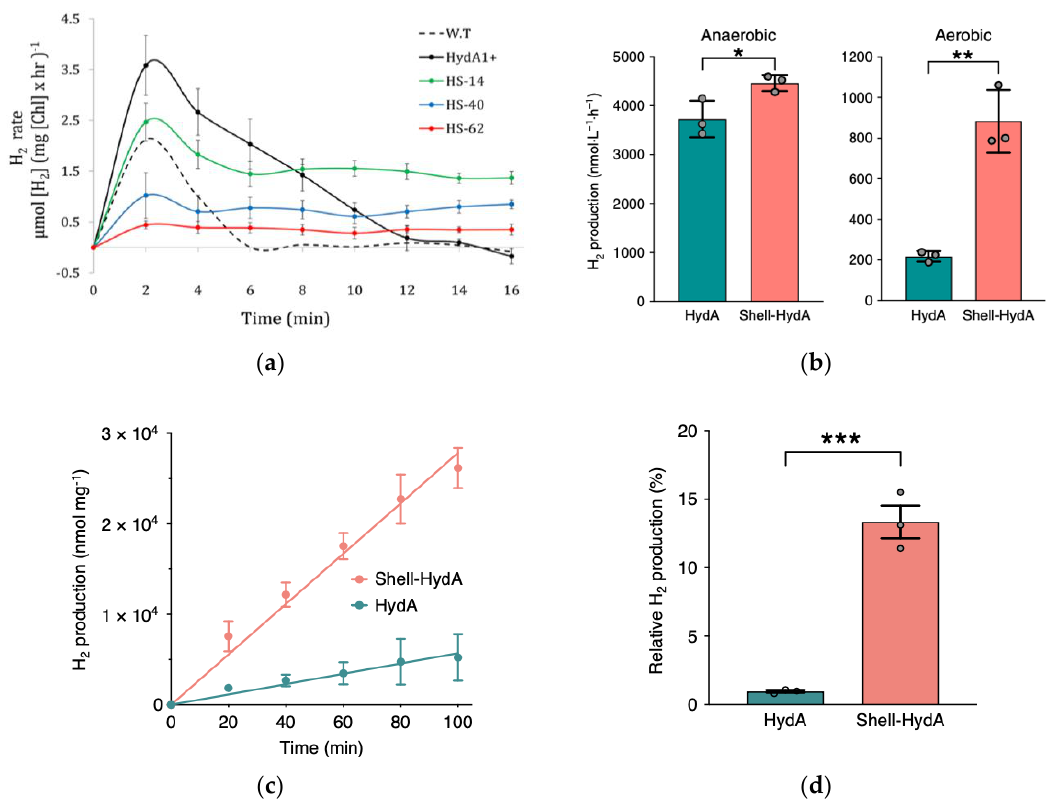
Figure 1. ( a ) HydA-SOD and clones of the complex rates of reaction over time. Reprinted with permission from ref. [3]. 2019 Springer Nature. ( b ) In vivo testing of anaerobic and aerobic pathways of H 2 production for Shell-HydA relative to free HydA enzyme (* signifies p = 0.0352 and ** signifies p = 0.0018). Reprinted with permission from ref. [41]. 2020 Springer Nature. ( c ) In vitro enzyme-mediated H 2 production over time of Shell-HydA composite relative to free HydA. Reprinted with permission from ref. [41]. 2020 Springer Nature. ( d ) Anaerobic relative H 2 production for Shell-HydA and lone HydA found through in vitro testing of activity following 24 h of exposure to O 2 at 4 °C (*** signifies p=0.0009). Reprinted with permission from ref. [41]. 2020 Springer Nature.